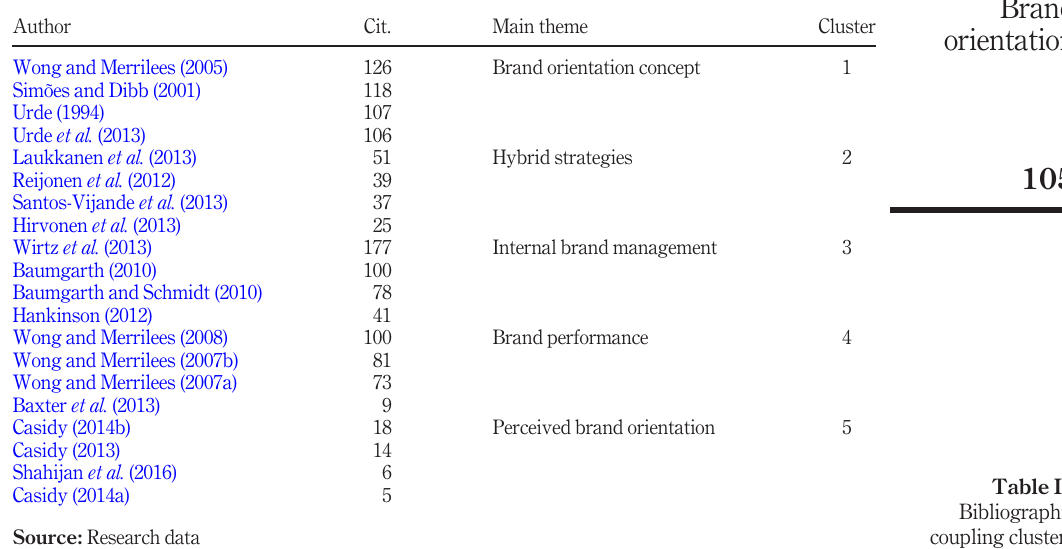
Table II. Bibliographic coupling